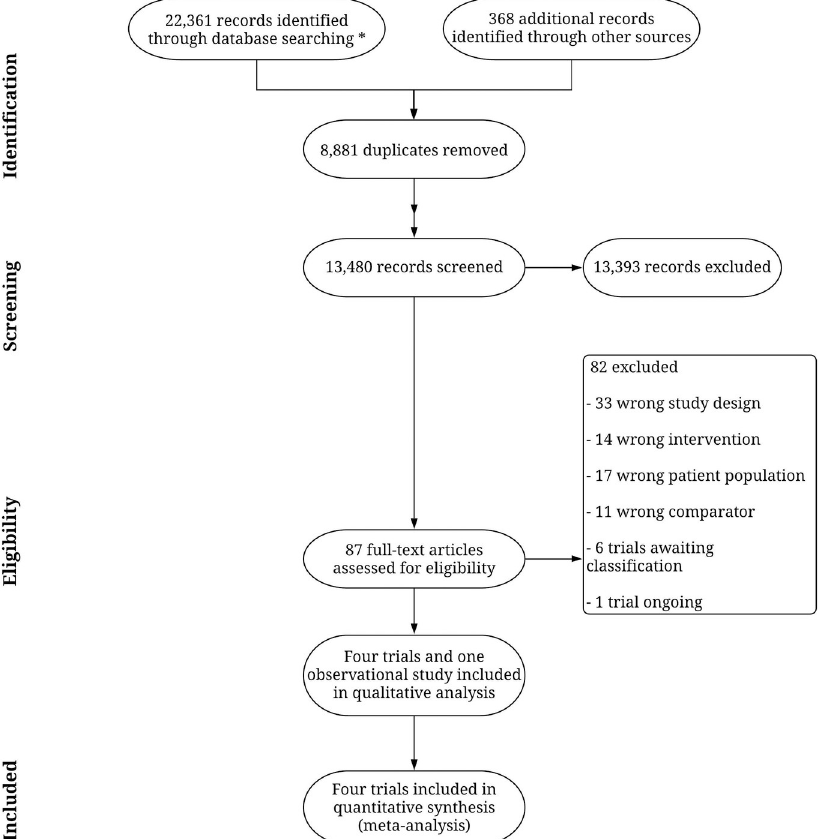
Fig 1. Flow chart. Study flow chart through the systematic review. � Detailed search history can be found in S1 Table in S1 File.